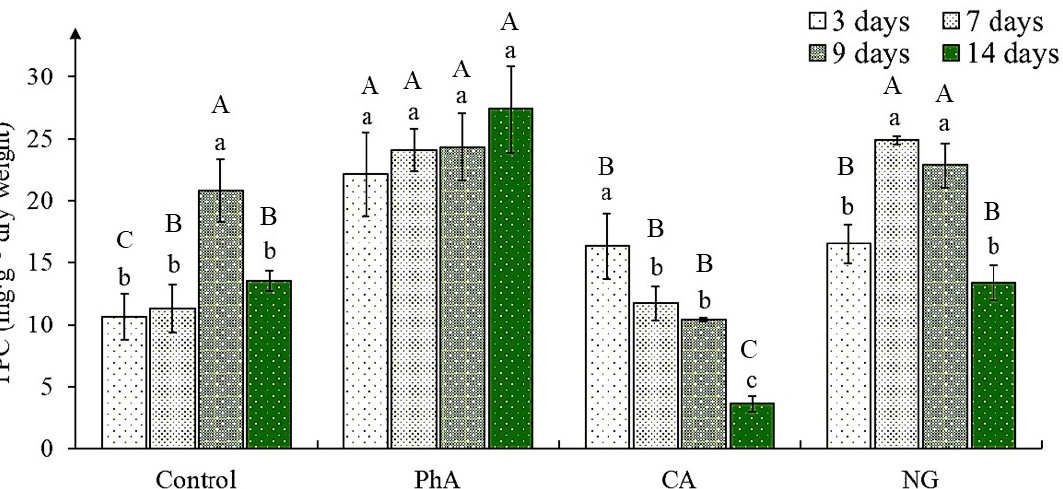
Figure 2. The total phenolic content (TPC) in tea callus cultures of various ages grown on the liquid Heller culture medium of the basic composition (Control) or enriched with L -phenylalanine (PhA; 3 mM), trans -cinnamic acid (CA; 1 mM) or naringenin (NG; 0.5 mM). Results are expressed as means ± SDs, n = 3. The significant differences at p < 0.05 are denoted by different Latin letters: uppercase letters indicate significant differences between precursor treatments in alphabetic order from highest to lowest, lowercase letters indicate significant differences between duration of precursor treatments in alphabetic order from highest to lowest. Pairwise multiple comparisons were carried out using Tukey’s range test.